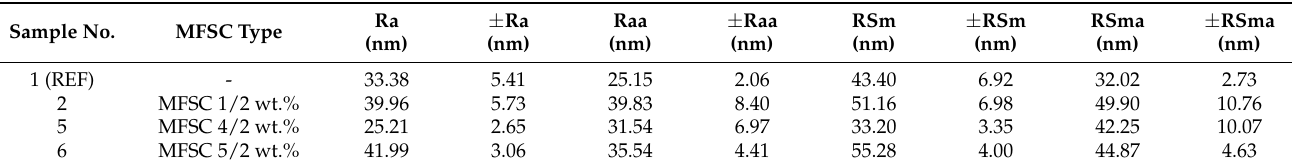
Table 3. The roughness parameters obtained by AFM before and after